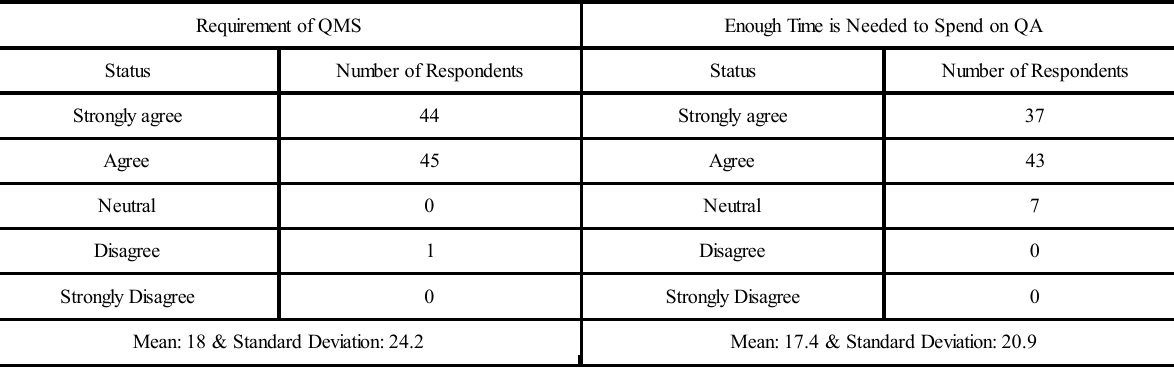
TABLE 1. NEED OF QUALITY MANAGEMENT SYSTEM & TIME FOR QUALITY ASSURANCE